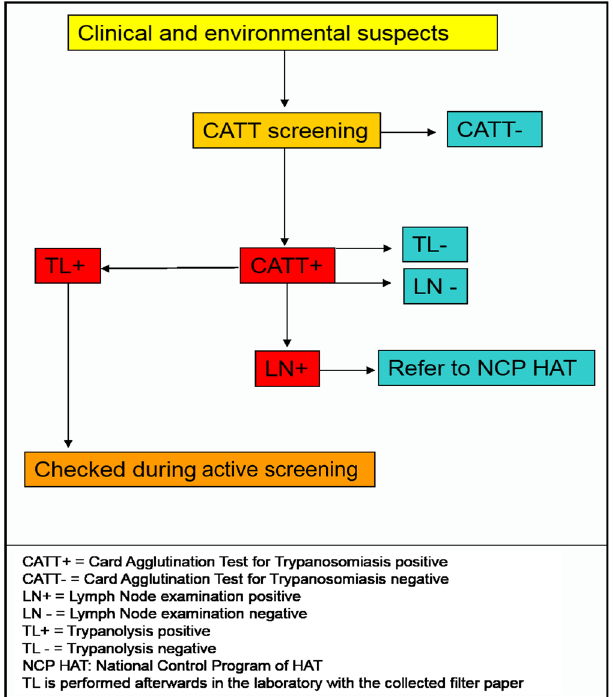
Figure 3. Medical diagnosis procedure during IVR. Clinical and environmental suspected cases are fi rst screened by CATT. If positive, the lymph nodes of individuals are examined. CATT- positive individuals who are negative for LN and TL are considered HAT-negative. All TL-positive subjects must be checked during the active screening. CATT+ = Card Agglutination Test for Trypanoso- miasis positive; CATT (cid:4) = Card Agglutination Test for Trypanoso- miasis negative; LN+ = Lymph Node examination positive; LN (cid:4) = Lymph Node examination negative; TL+ = Trypanolysis positive; TL (cid:4) = Trypanolysis negative; NCPHAT: National Control Programme of HAT. TL is performed afterwards in the laboratory with the collected fi lter paper.